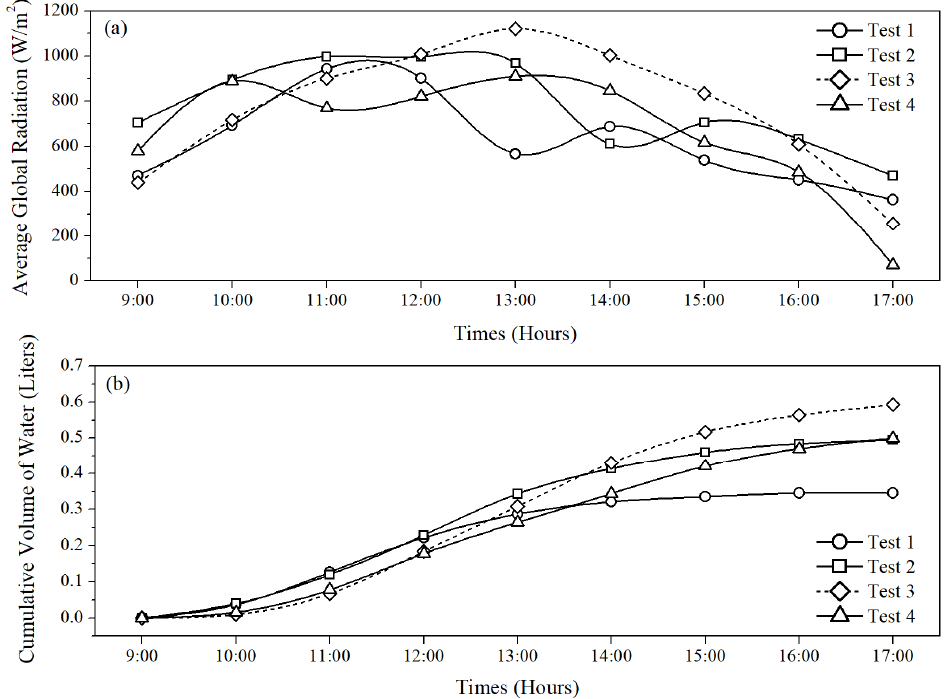
Figure 6. ( a ) Average global radiation (W/m 2 ). ( b ) Accumulative water volume.